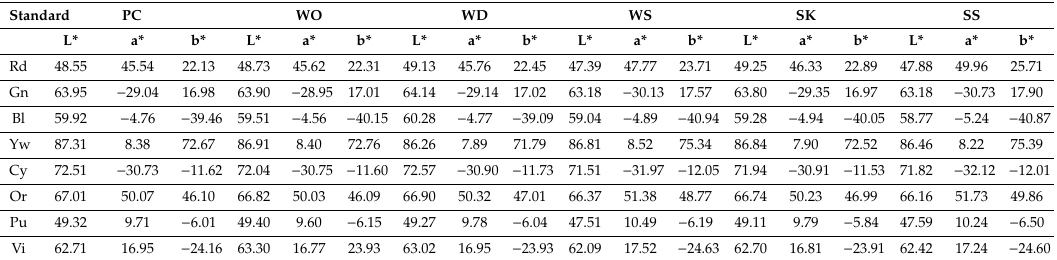
Table 4. CIELAB coordinate values for the standards obtained by varying the scale adjustment procedures.